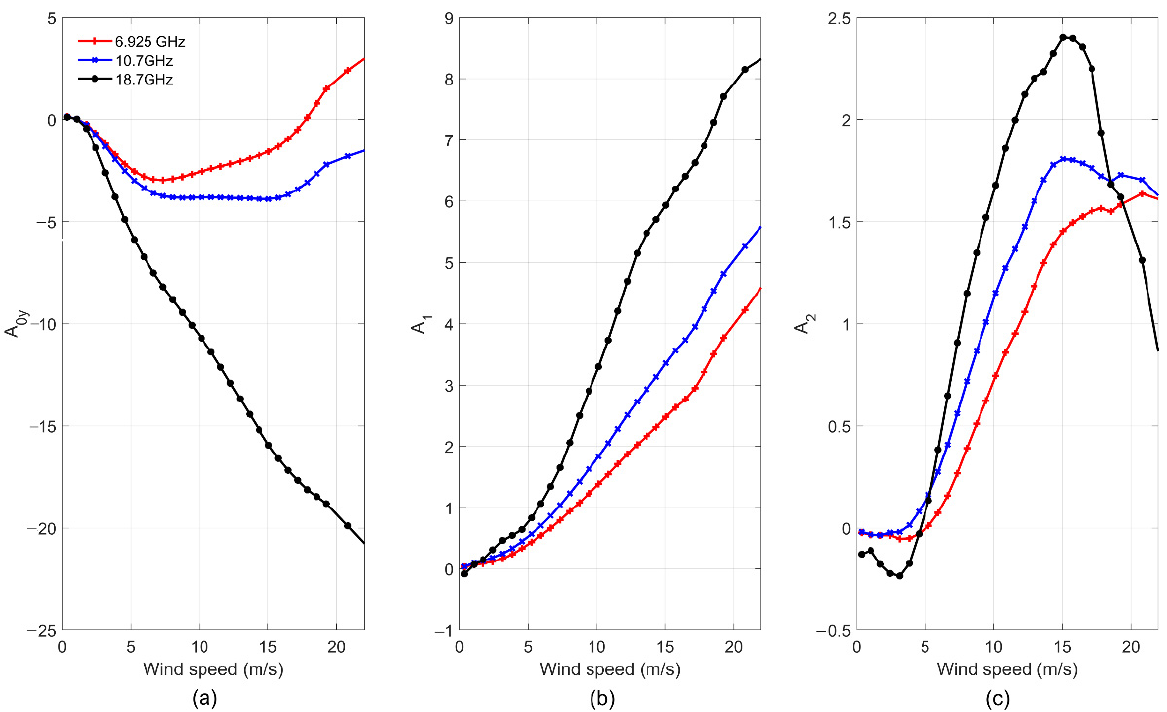
Figure 7. The dependence of AVH on SST: ( a ) 6.925 GHz, ( b ) 10.7 GHz, and ( c ) 18.7 GHz.